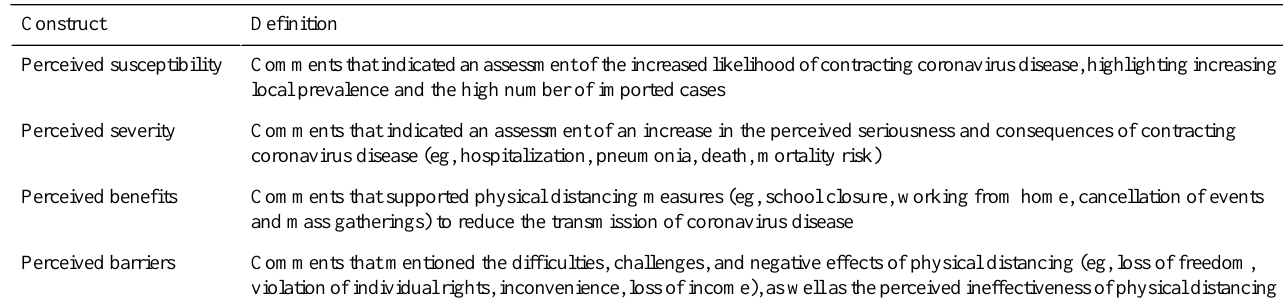
Table 1. Definition of the Health Belief Model constructs examined and sample comments in relation to coronavirus disease.